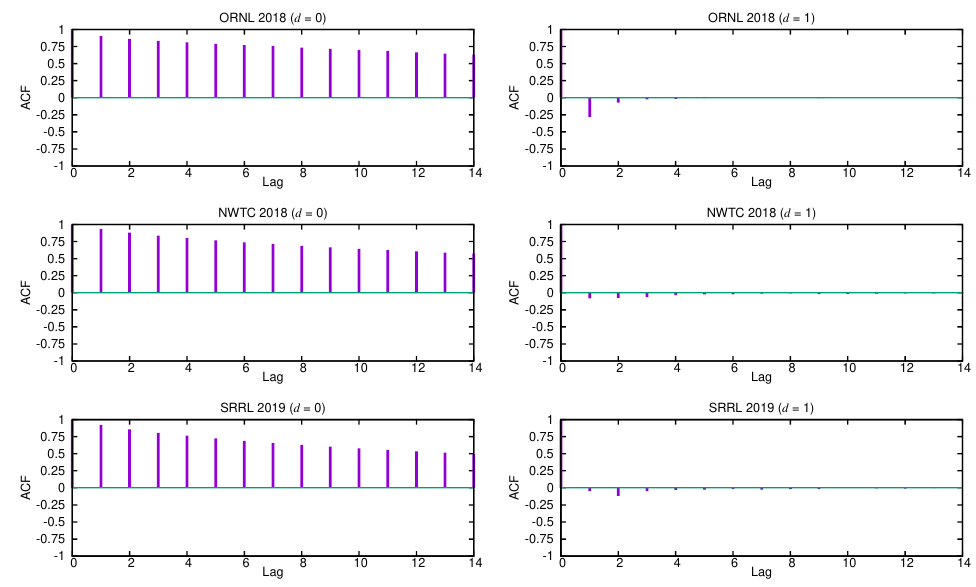
Figure 2. Autocorrelation functions (ACFs) for d = 0 and d = 1.